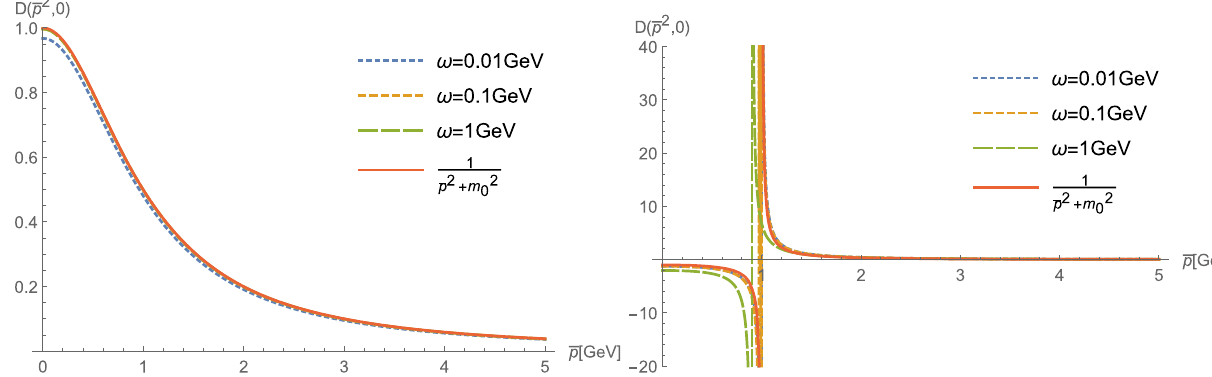
types of masses, real mass with m 0 = 1 GeV ( left panel ) and purely imaginary mass with m 0 = i GeV ( right panel